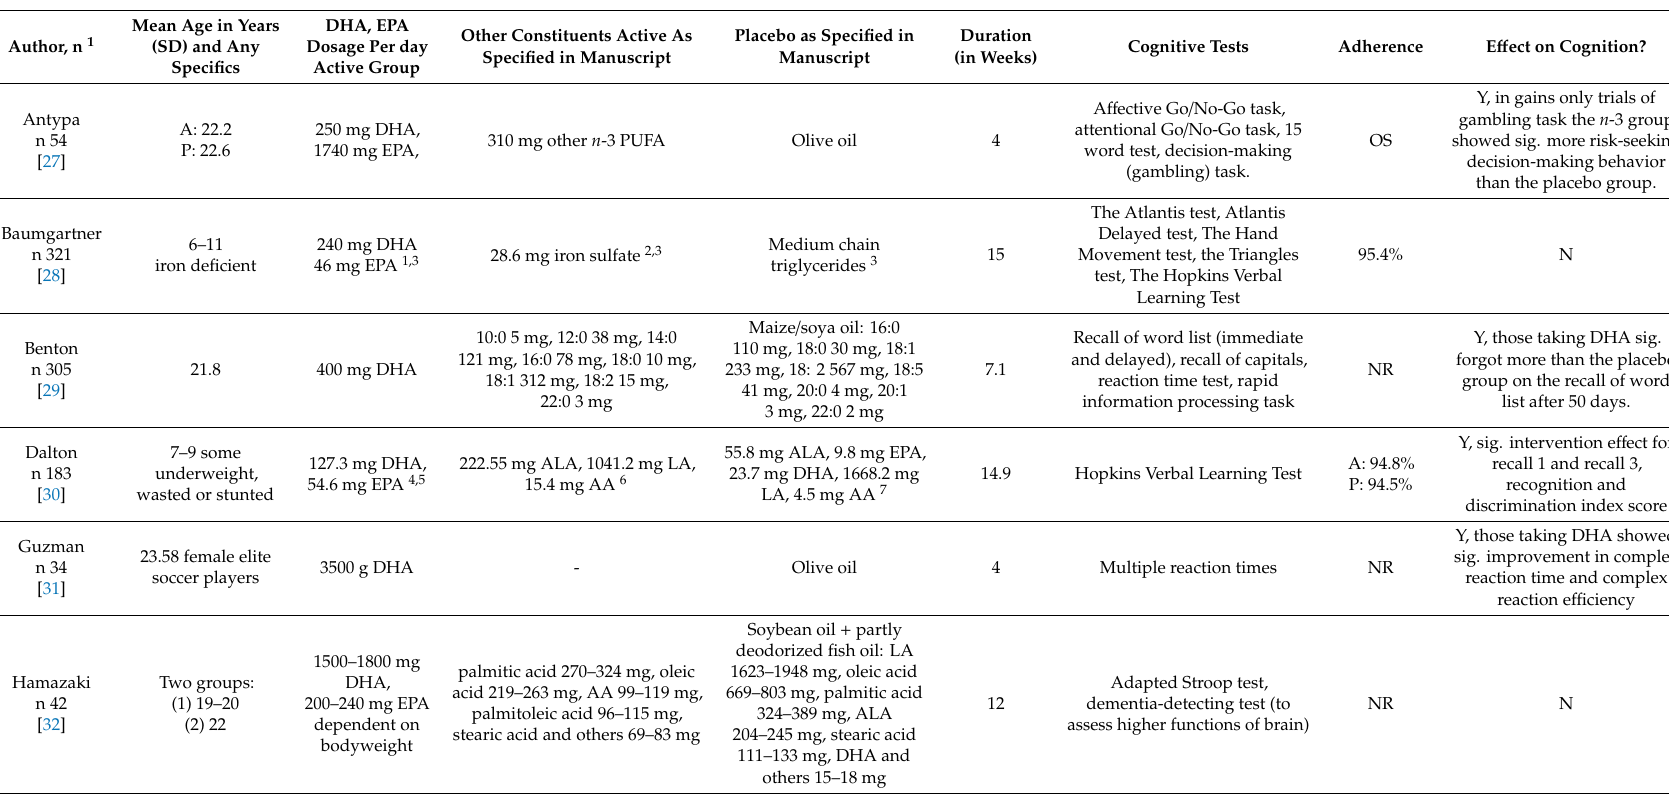
Table 1. Overview of studies supplementing children and adolescents with long chain polyunsaturated fatty acids (LCPUFA) and including a cognitive measure as outcome